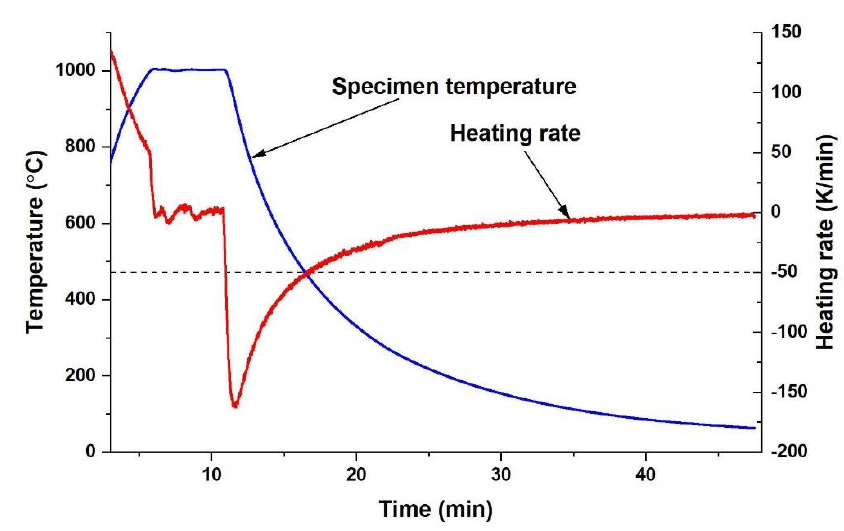
Figure 10. Heating rate of specimens after the PAIS process.